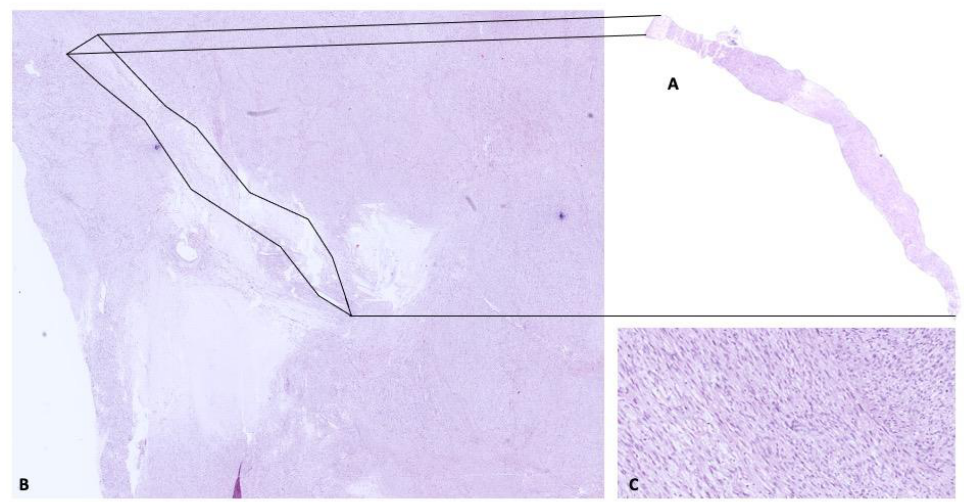
Figure 2. A CT-guided diagnostic core biopsy ( A ) was performed, retrieving a representative amount of tissue from the mediastinal mass. ( B ) Unfortunately, the needles punctured a low-grade area devoid of cytologic atypia, and mitotic figures CEE stain A and B (1.2 original magnification) ( C ) (20 × original magnification).